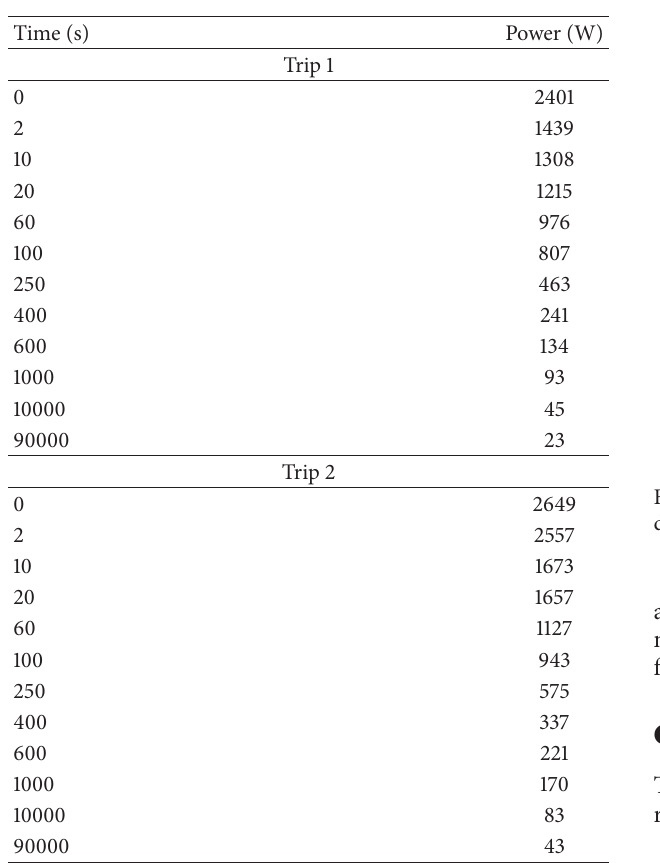
Table 3: Transient decay heat during first (Trip 1) and second (Trip 2) shutdown conditions.